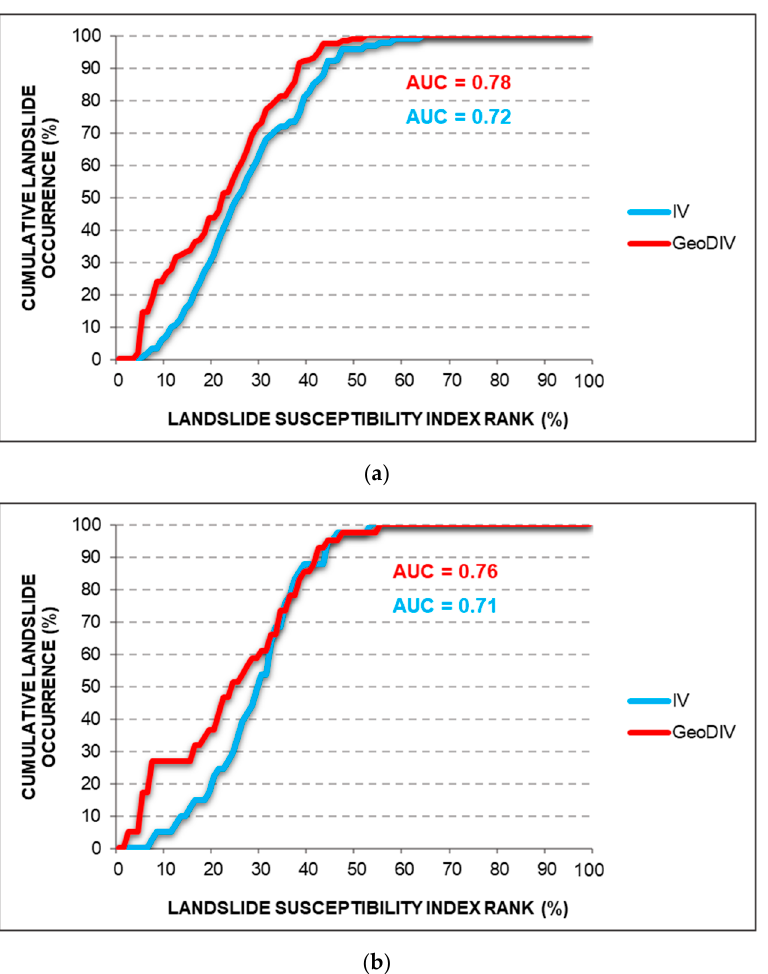
Figure 9. The results of the validation procedure: ( a ) success rate curves; ( b ) prediction rate curves.